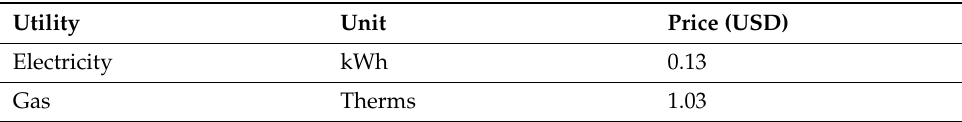
Table 6. Utility unit cost of the